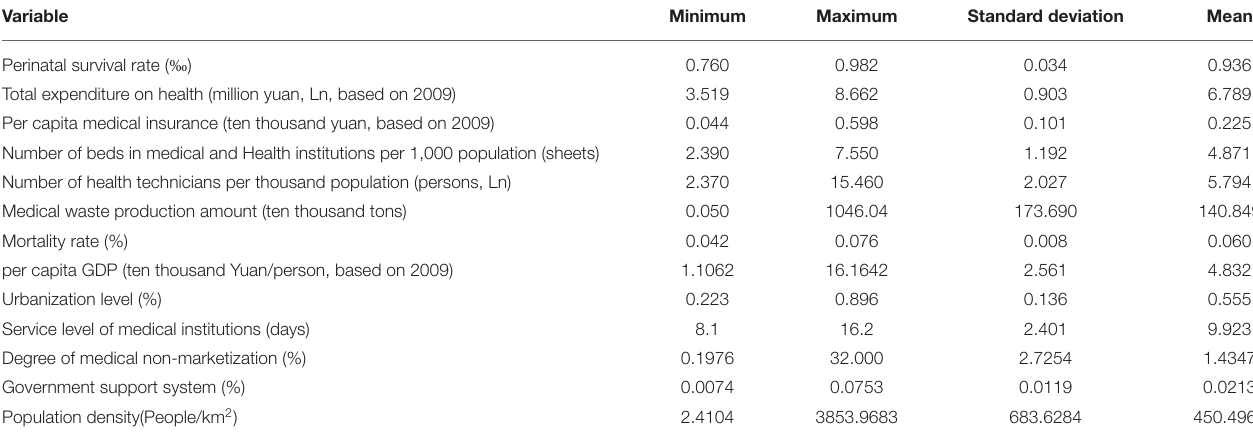
TABLE 2 | Descriptive statistics of variables.